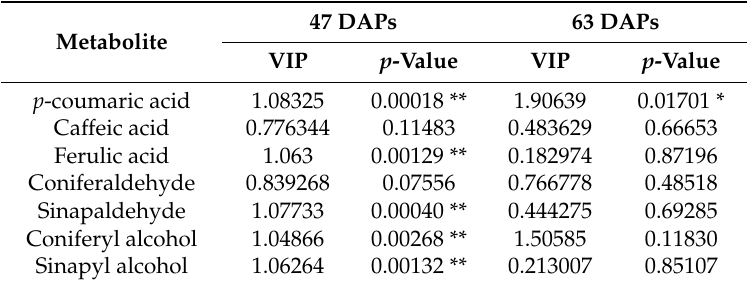
Figure 7. Orthogonal partial least squares-discriminant analysis (OPLS-DA) of lignin metabolites derived from LC-MS. ( A ): 47 DAPs; ( B ): 63 DAPs. Table 4. The differential intermediate metabolites in lignin synthesis.